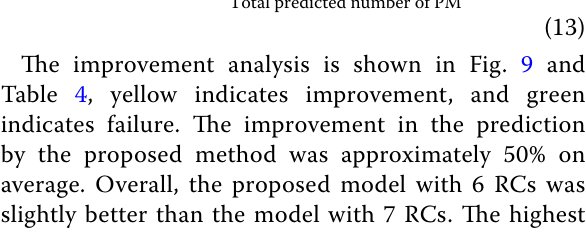
Table 3 MAE statistics of various models (mas) Lead